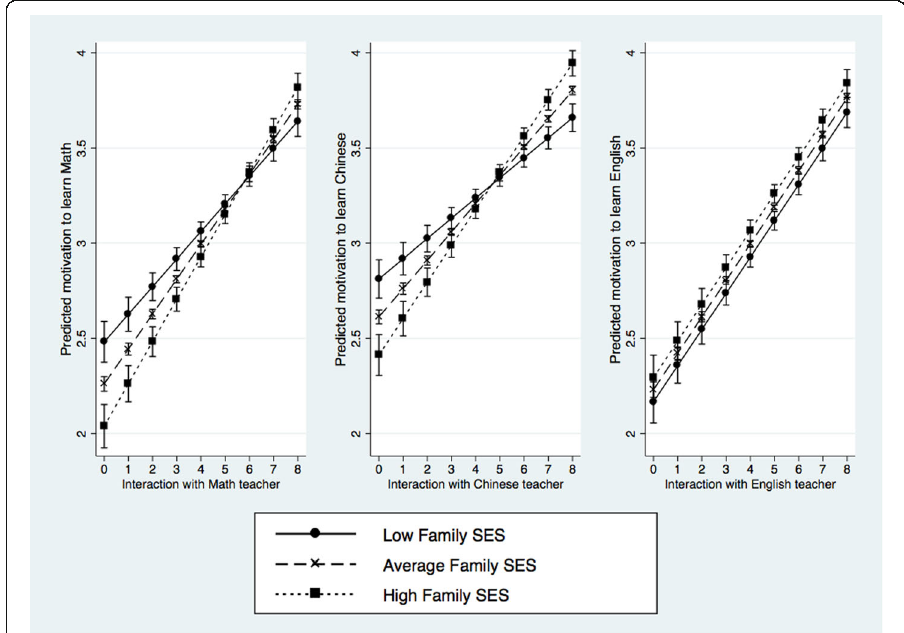
Fig. 1 Predicting learning motivation with student-teacher interaction by family backgrounds. Average family SES is the group with family SES exactly at the mean. Low family SES group is the group that is two standard deviations below the mean. High family SES group is the group that is two standard deviations above the